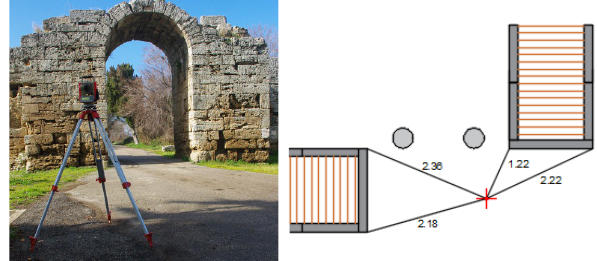
Figure 2. Total Station